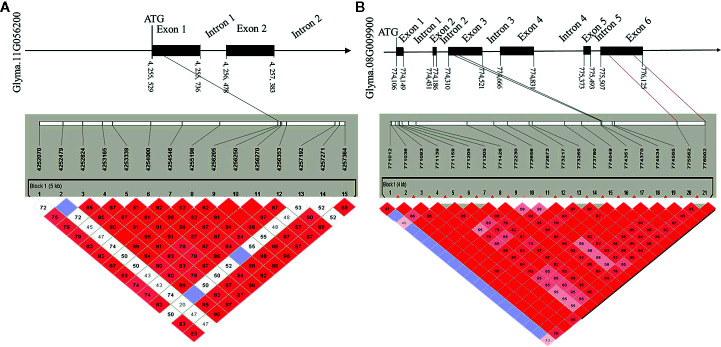
Candidate gene structure in 200 CSSL lines. (A) the SNP (single nucleotide polymorphisms) of Glyma. 11G056200 distribution in promoter, exon and intron region. (B) the SNP of Glyma. 08G009900 distribution in promoter, exon and intron region.